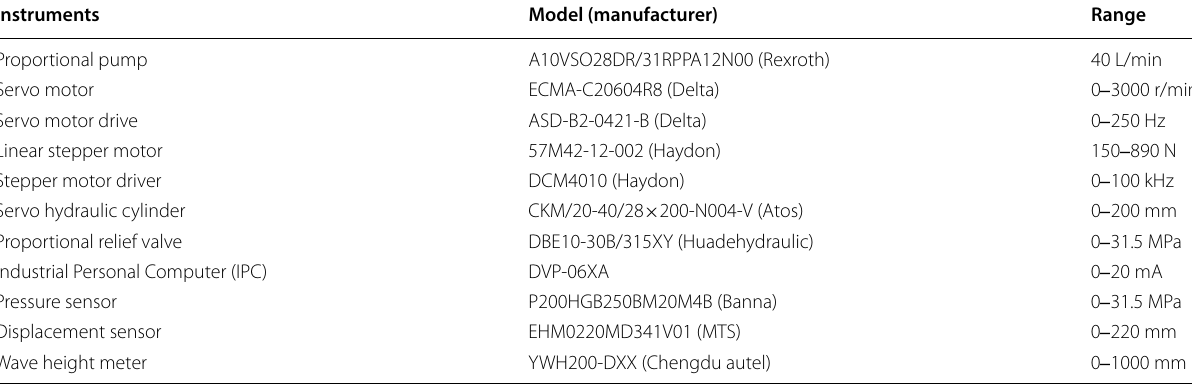
Table 1 Experimental